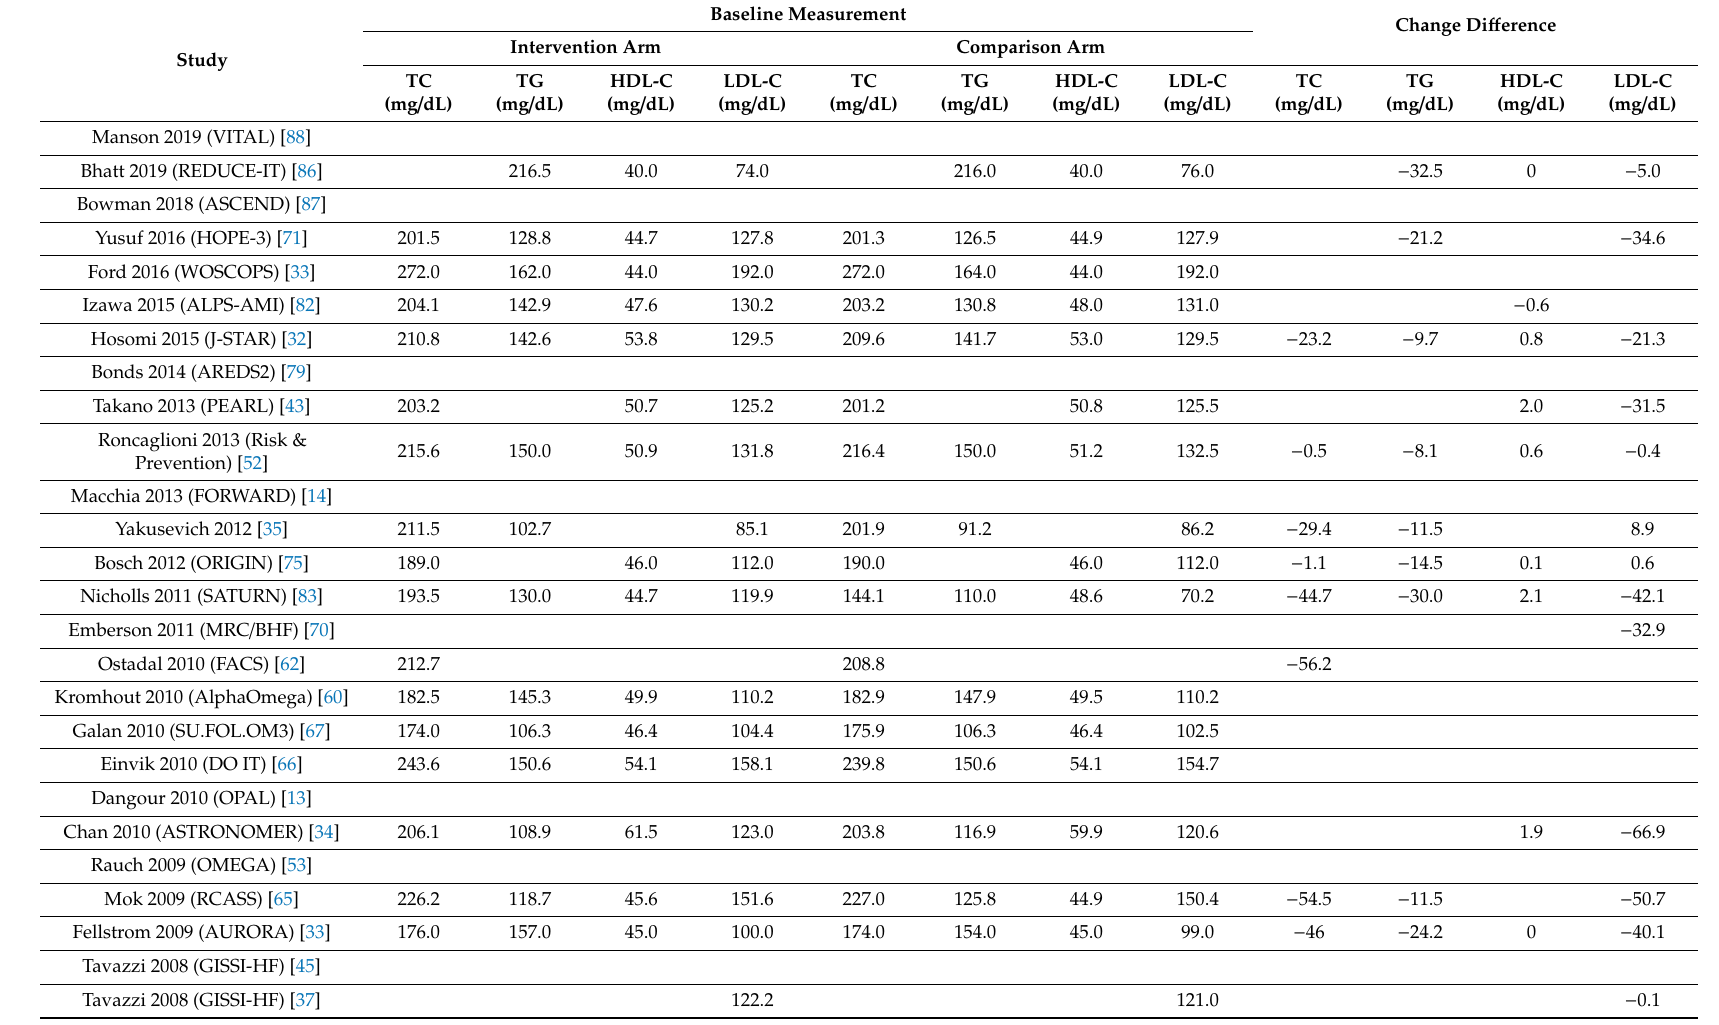
Table 2. Lipid profiles of study